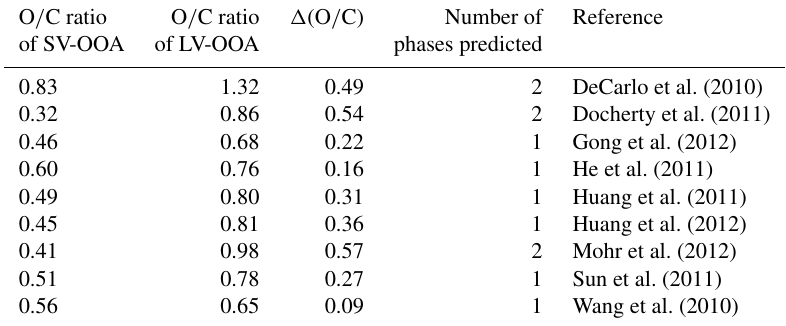
Table A2. Overview of O / C ratios reported for SV-OOA and LV-OOA components when sampling ambient organic aerosol. Elemental O / C ratios were calculated using the improved ambient method and data taken from Canagaratna et al. (2015). Also indicated is the (cid:49) (O / C) value between the SV-OOA and LV-OOA components and the number of phases predicted using a (cid:49) (O / C) threshold value of 0.47 (Fig. 4). O / C ratio O / C ratio (cid:49) (O / C) Number of Reference of SV-OOA of LV-OOA phases predicted